Question: In a single sentence, describe what this figure presents.
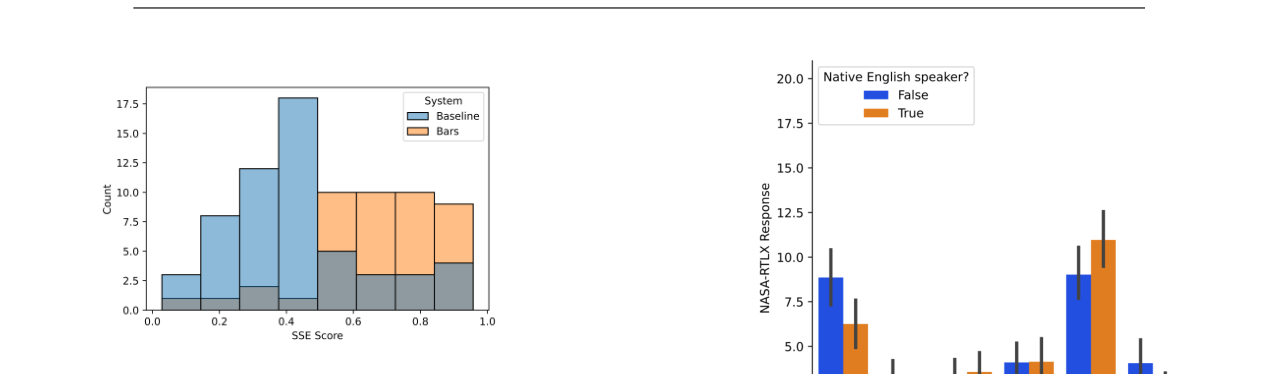
Answer: Distribution of SSE scores. Results from a Wilcoxon signed rank test (T = 98.0, p < 0.001) indicate there is a statis- tically significant difference in scores between systems.